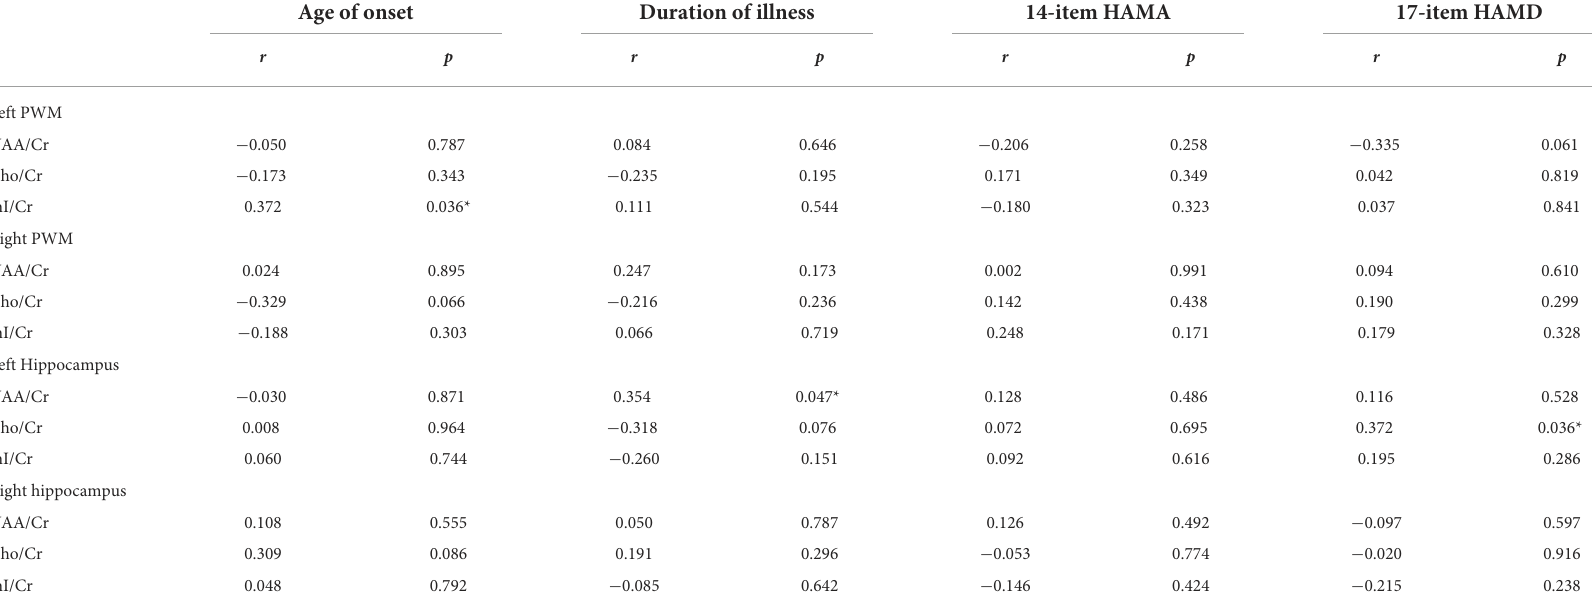
TABLE 4 Correlations between biochemical metabolite ratios and clinical variables in BD patients with SI. Age of onset Duration of illness 14-item HAMA 17-item